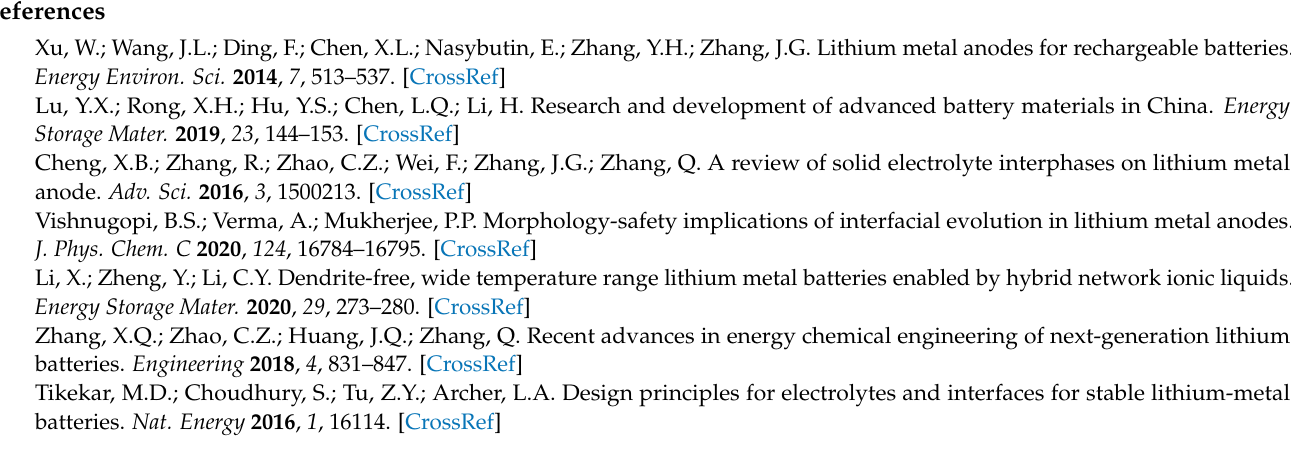
properties, Figure S3: Nyquist plot, Figure S4: Lithium transference number measurement, Figure S5: Galvanostatic polarization